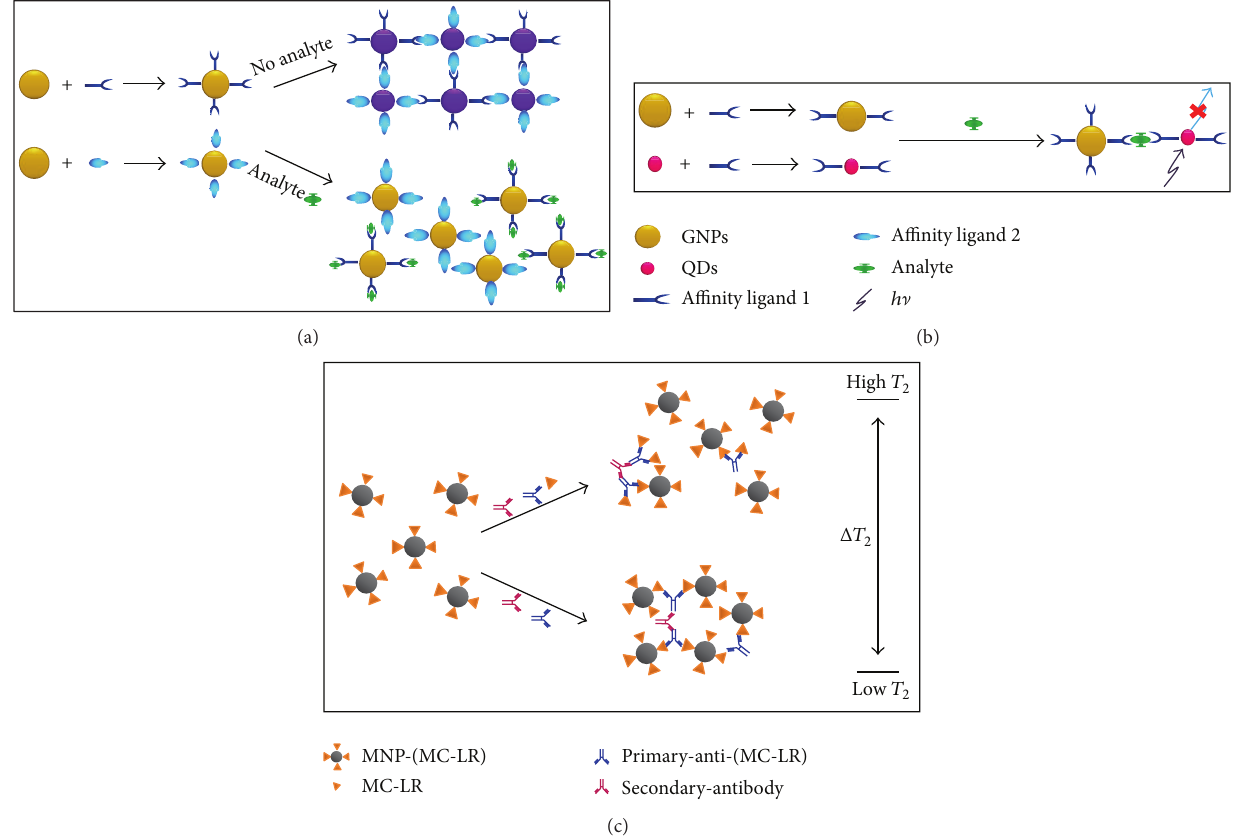
Figure 3: Scheme depicting principle of biosensor-based detection using (a) gold nanoparticles and (b) quantum dots as well as (c) magnetic nanoparticle aggregates for detection of microcystin-LR (MC-LR), naturally occurring toxin produced from